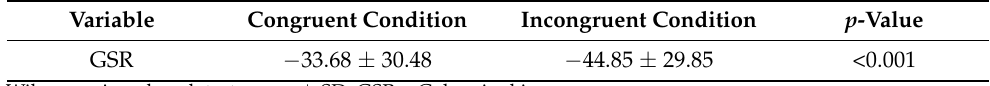
Table 1. Comparison of GSR between the congruent and incongruent conditions.